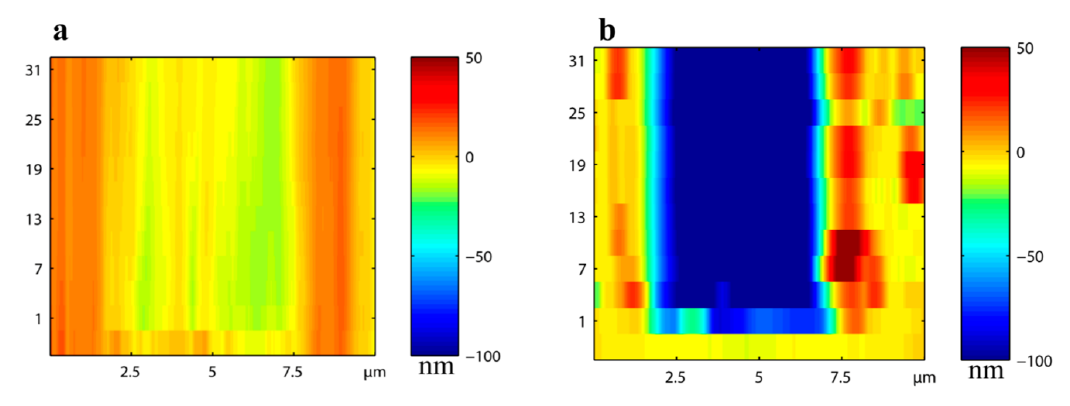
Figure 5. Wear evolution maps for ( a ) Hier-TaN/Ta coating, and ( b ) Ti6Al4V substrate. The Y-axis indicates the number of cycles to produce wear, the X-axis is the width of the wear track, and the bar scale represents the wear depth in nanometers.